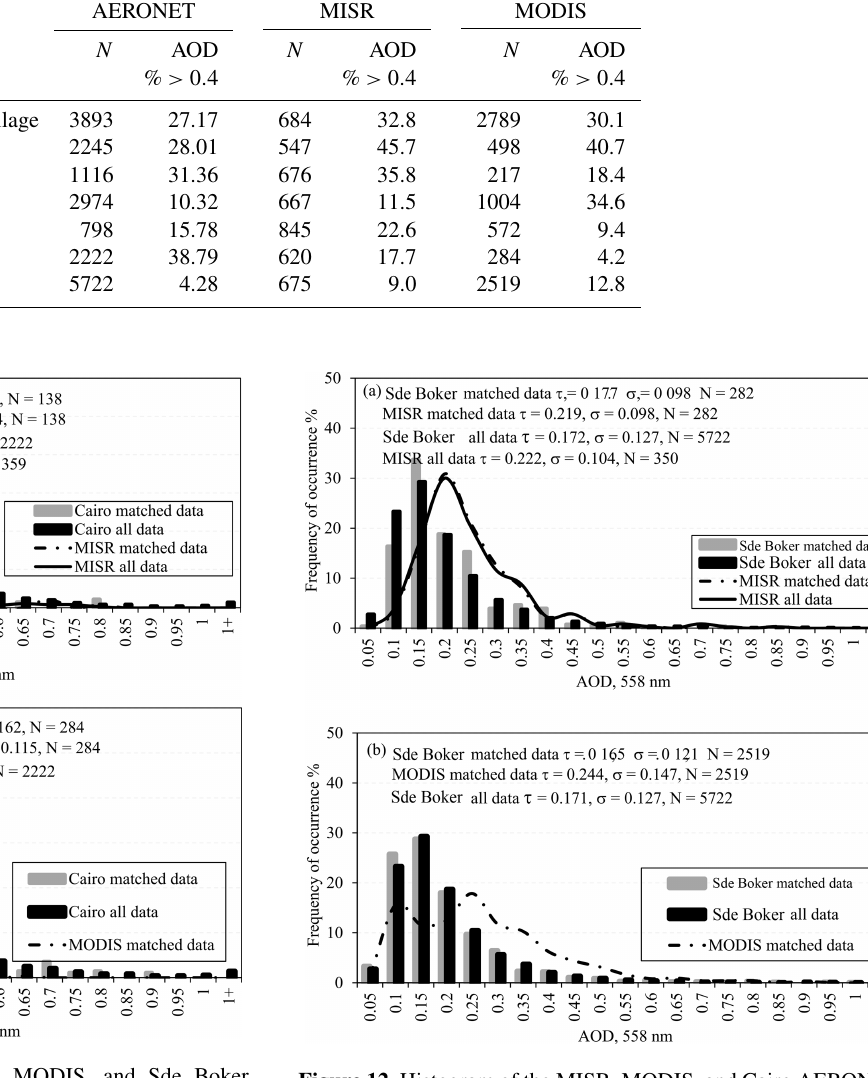
Figure 12. Histogram of the MISR, MODIS, and Cairo AERONET measurements (a) MISR and (b) MODIS data